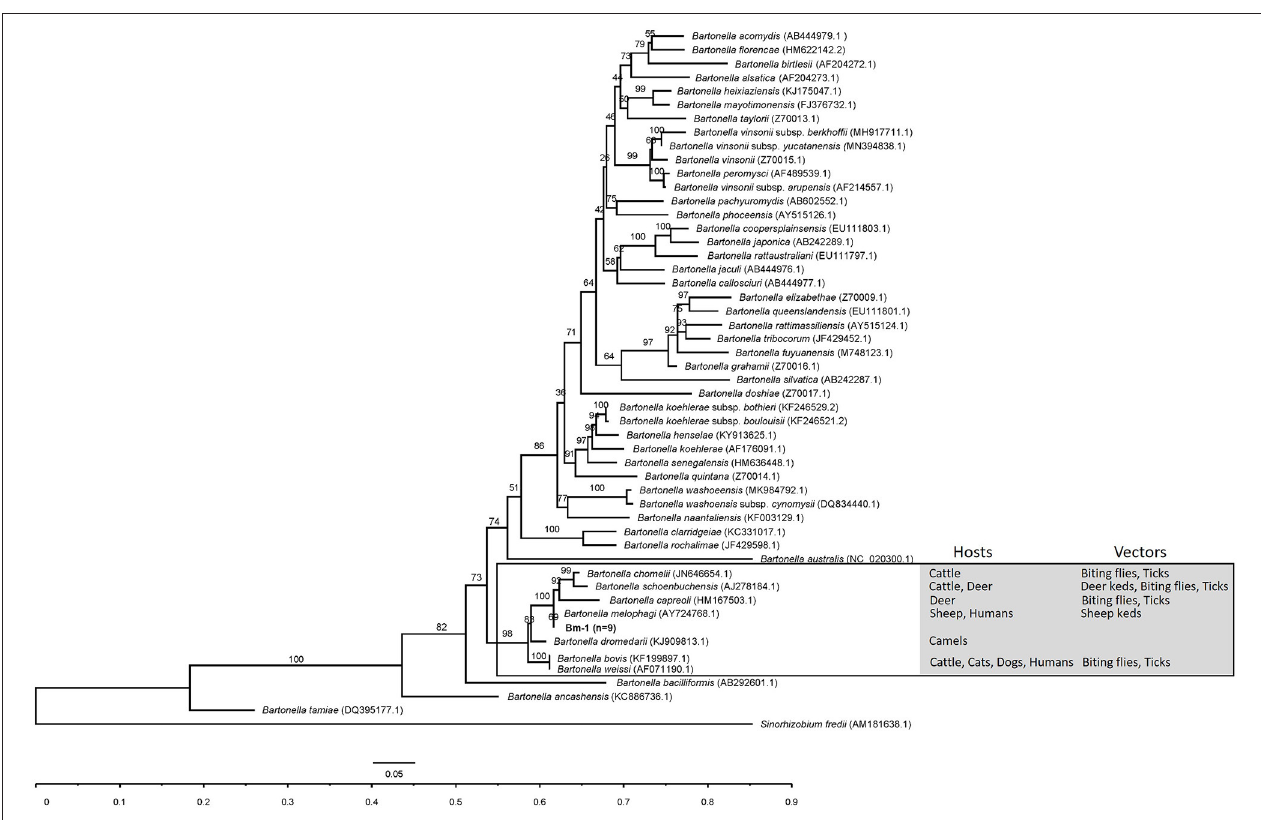
FIGURE 2 | The phylogenetic tree of Bartonella gltA sequences was constructed by using maximum likelihood (ML) and GTR + I + G4 + F as evolutionary models. The sequences detected in this study are shown in bold, and the numbers at the nodes correspond to bootstrap values. Sinorhizobium fredii was used as the out group.